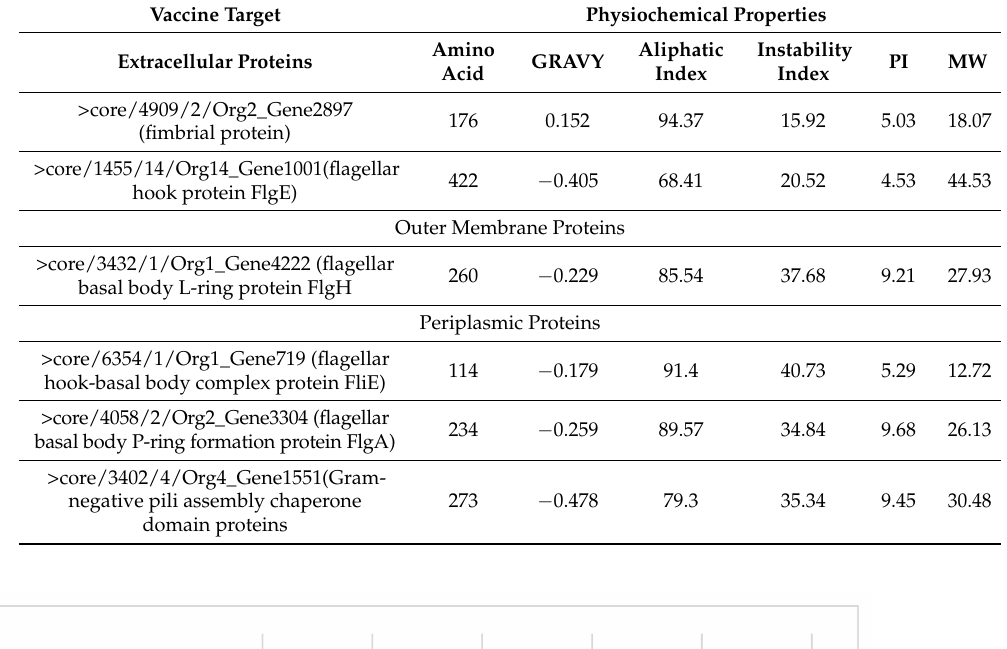
Table 1. Physiochemical properties of shortlisted proteins. Molecular weight (MW), isoelectric point (PI). Vaccine Target Physiochemical Properties